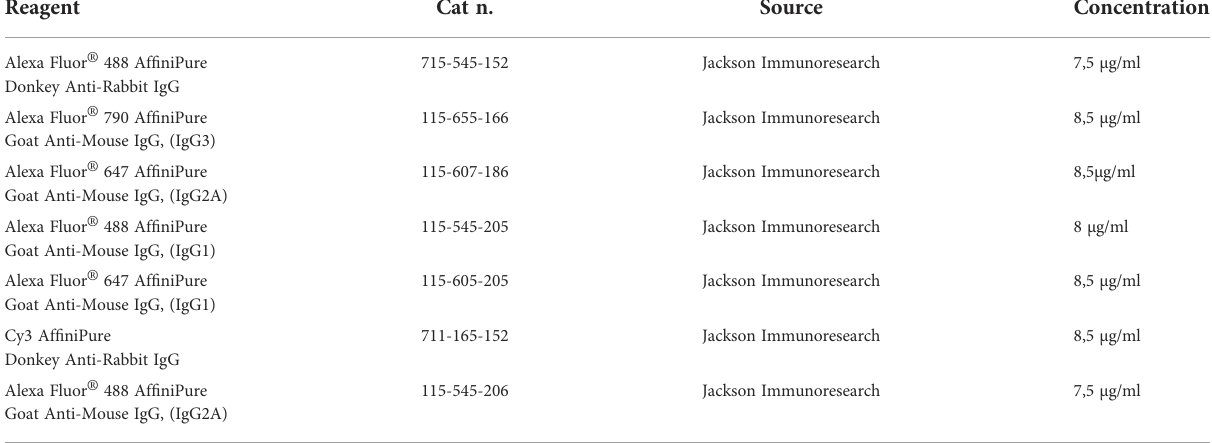
TABLE 2 List of the employed Secondary Antibodies. Reagent